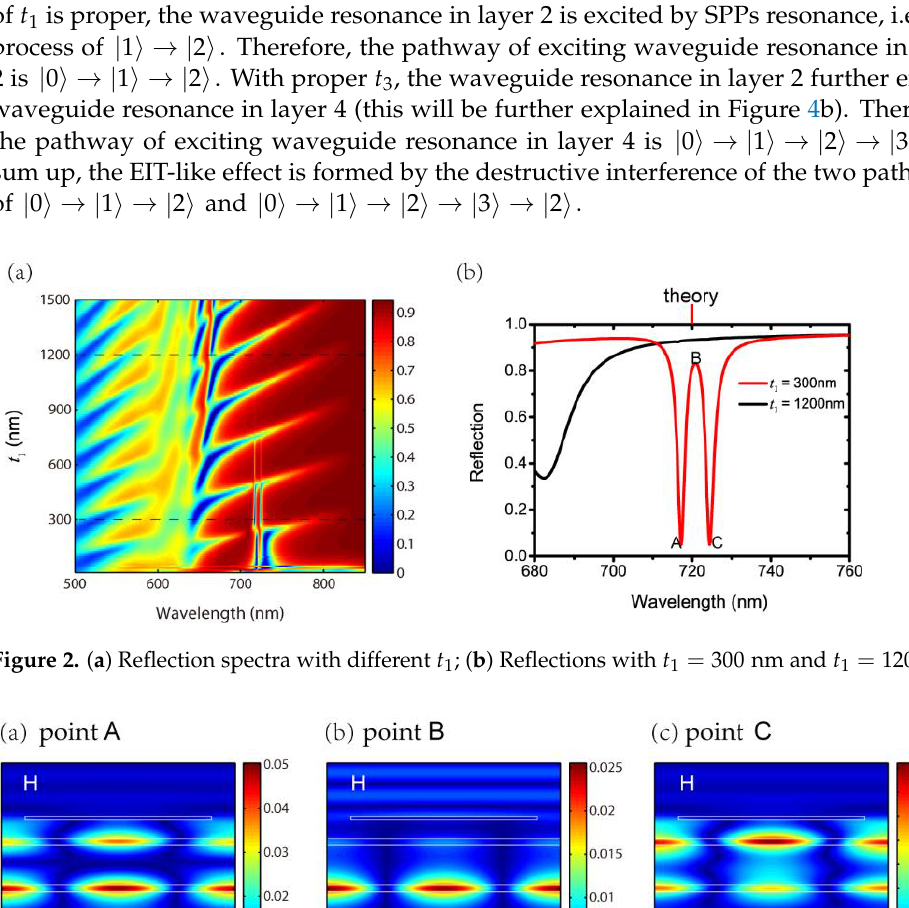
Figure 3. Magnetic field distributions of points ( a ) A, ( b ) B and ( c ) C in Figure 2b.